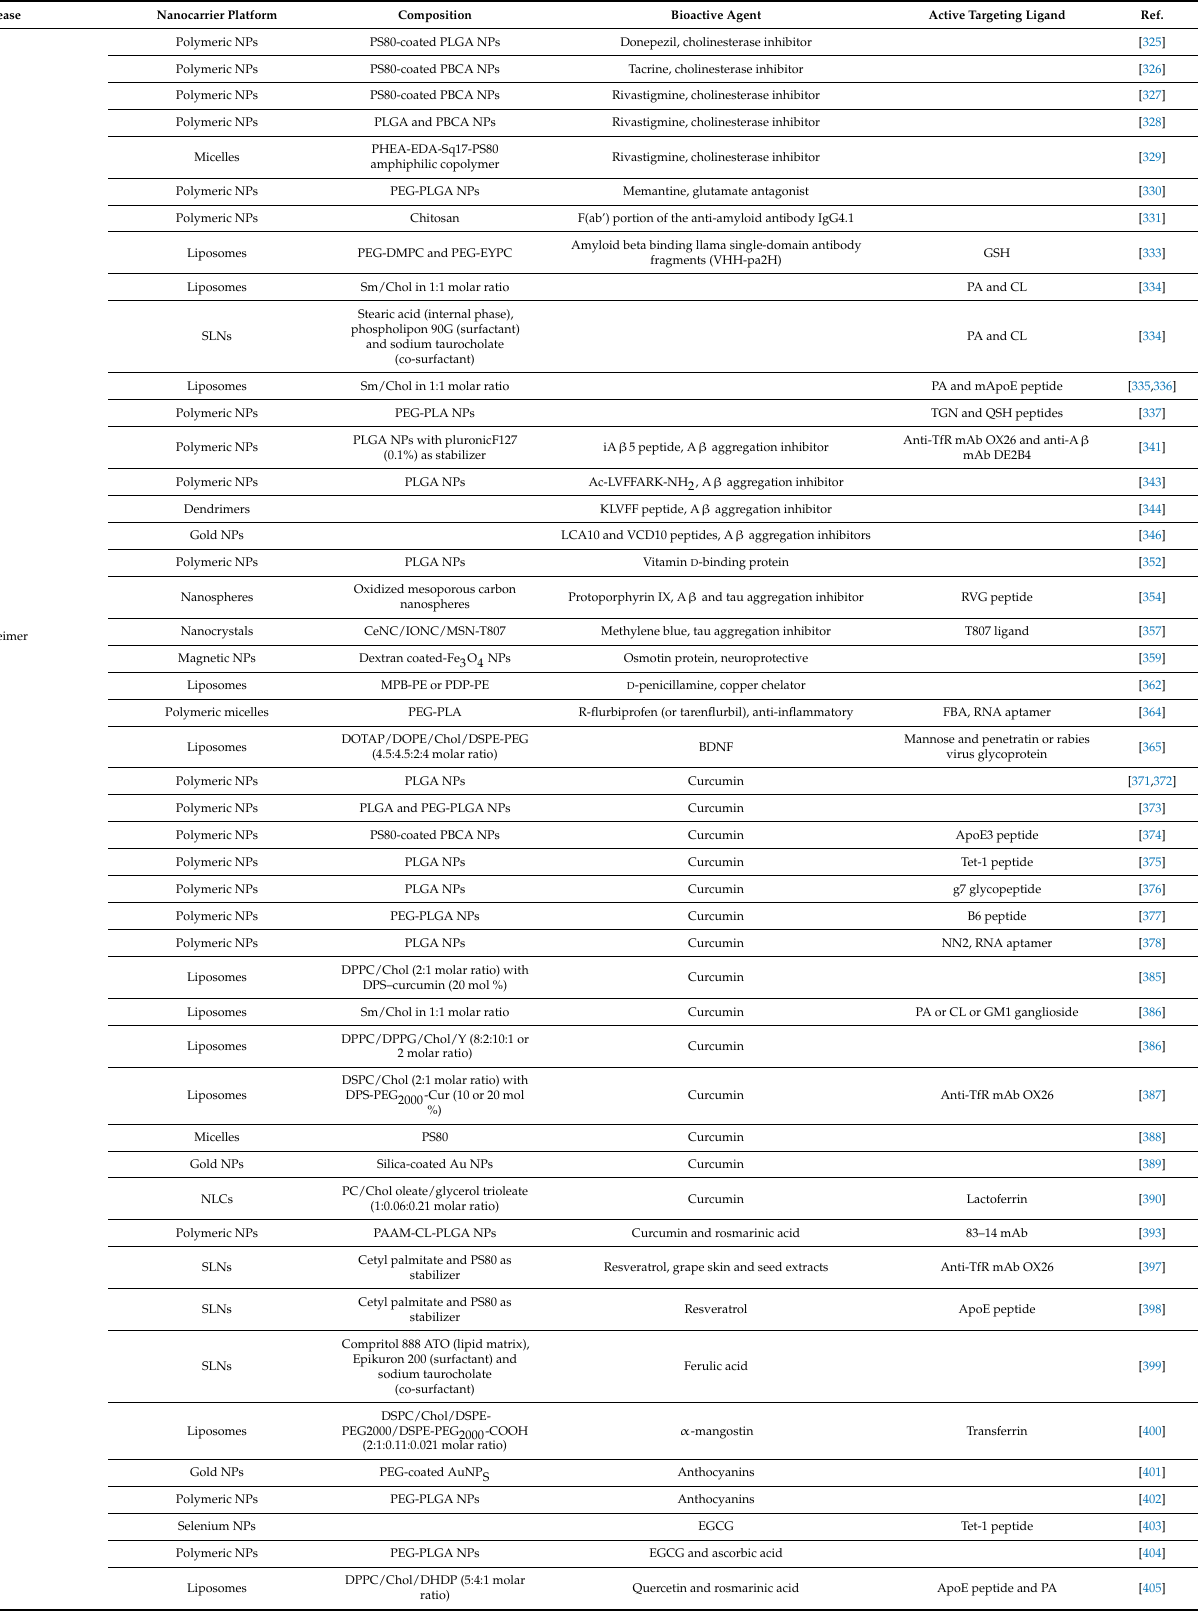
Table 1. Nanosystems for therapeutic applications in neurodegenerative diseases.